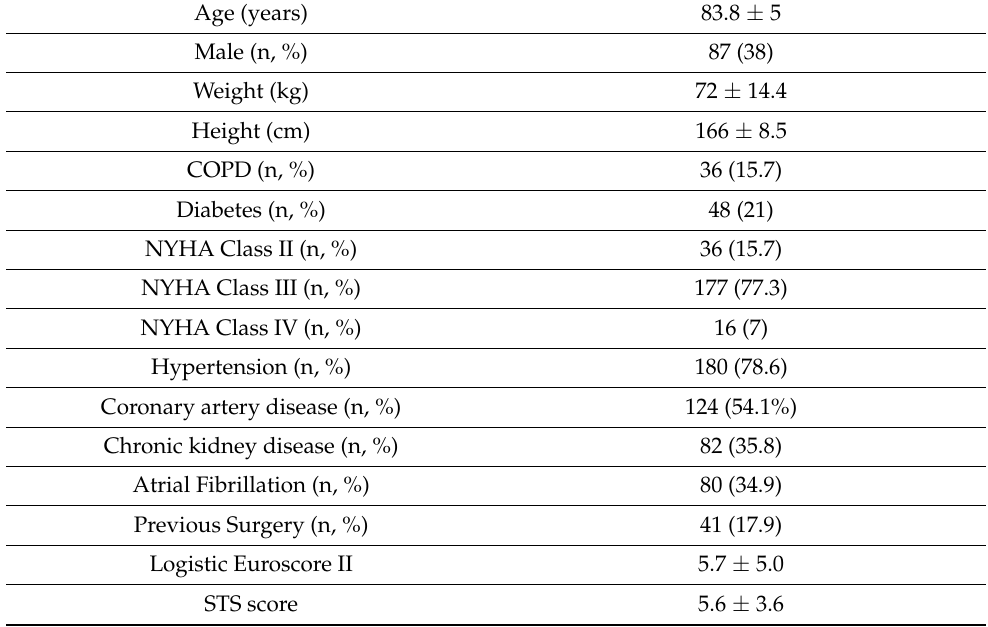
Table 1. Baseline